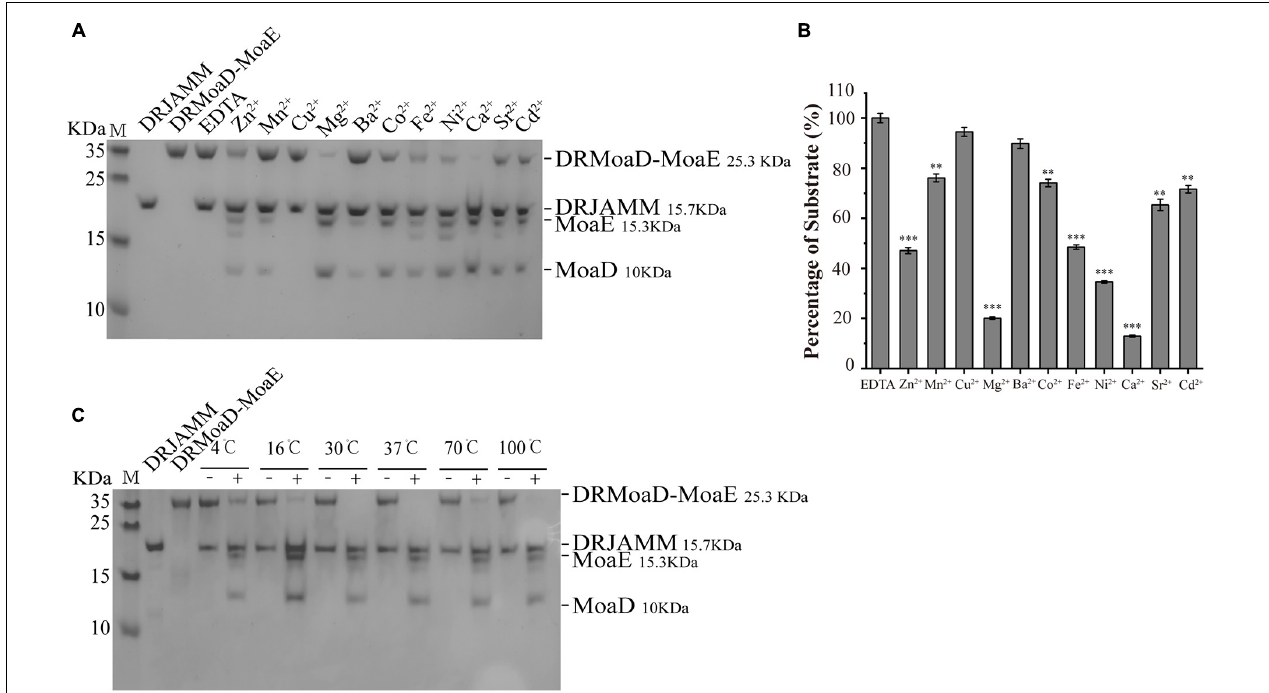
FIGURE 1 | The metal ion preference and temperature adaptability of DRJAMM activity. (A) Analysis of ion effects on DRJAMM function. The reaction of 10 µ M DRMoaD-MoaE and 40 µ M DRJAMM was incubated at 37 ◦ C for 30 min with 0.4 mM metal ions. Products were separated with Tricine-SDS-PAGE. (B) Values are the means of three independent assays (mean ± SD), ∗∗ p < 0.01, ∗∗∗ p < 0.001. (C) Analysis of temperature effects on DRJAMM function. Reactions were conducted similar to panel A but with the temperature gradient increased from 4 to 100 ◦ C. “ − ” represents EDTA control, “ + ” represents Ca 2 +